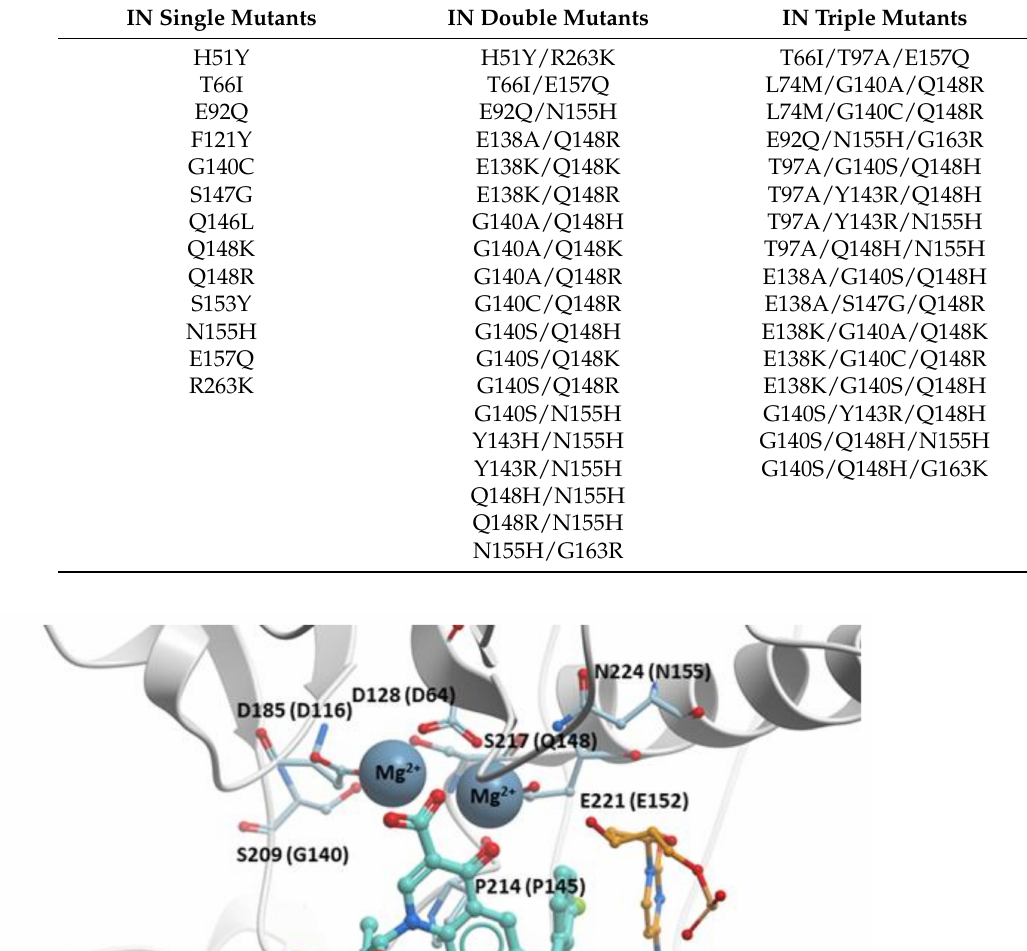
Table 2. Identification of elvitegravir (EVG)-resistant mutants. IN single, double, and triple mutants that have been selected against RAL in patients, in vitro selection studies, or IN susceptibility assays are listed.